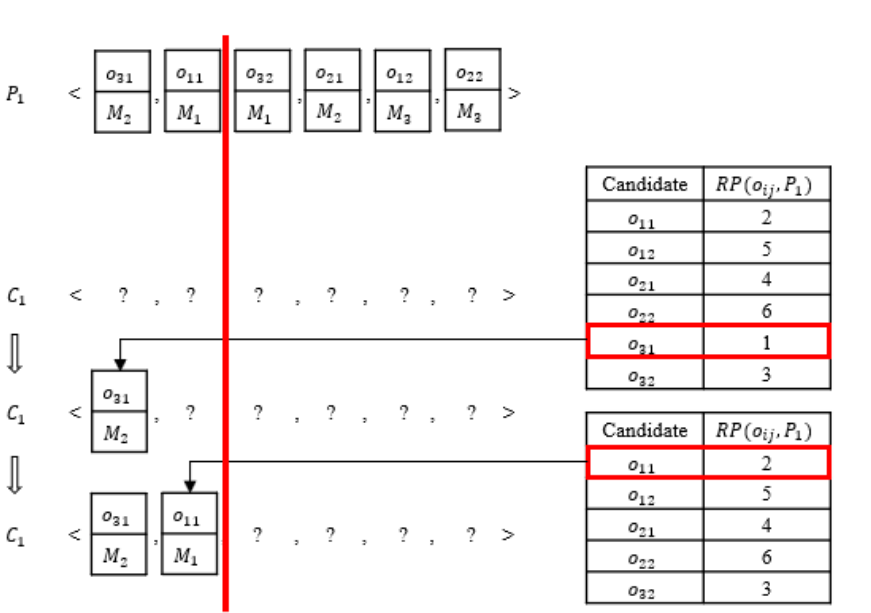
Figure 5. Generating the later part of the offspring solution. In contrast, the mutation operation for the 𝑝 th position of a new solution is per- formed by choosing a candidate with the largest reference position in the COGO proce- dure. That is, crossover and mutation are integrated in the COGO. Assume that 𝑜 (cid:3036)(cid:3037) is the